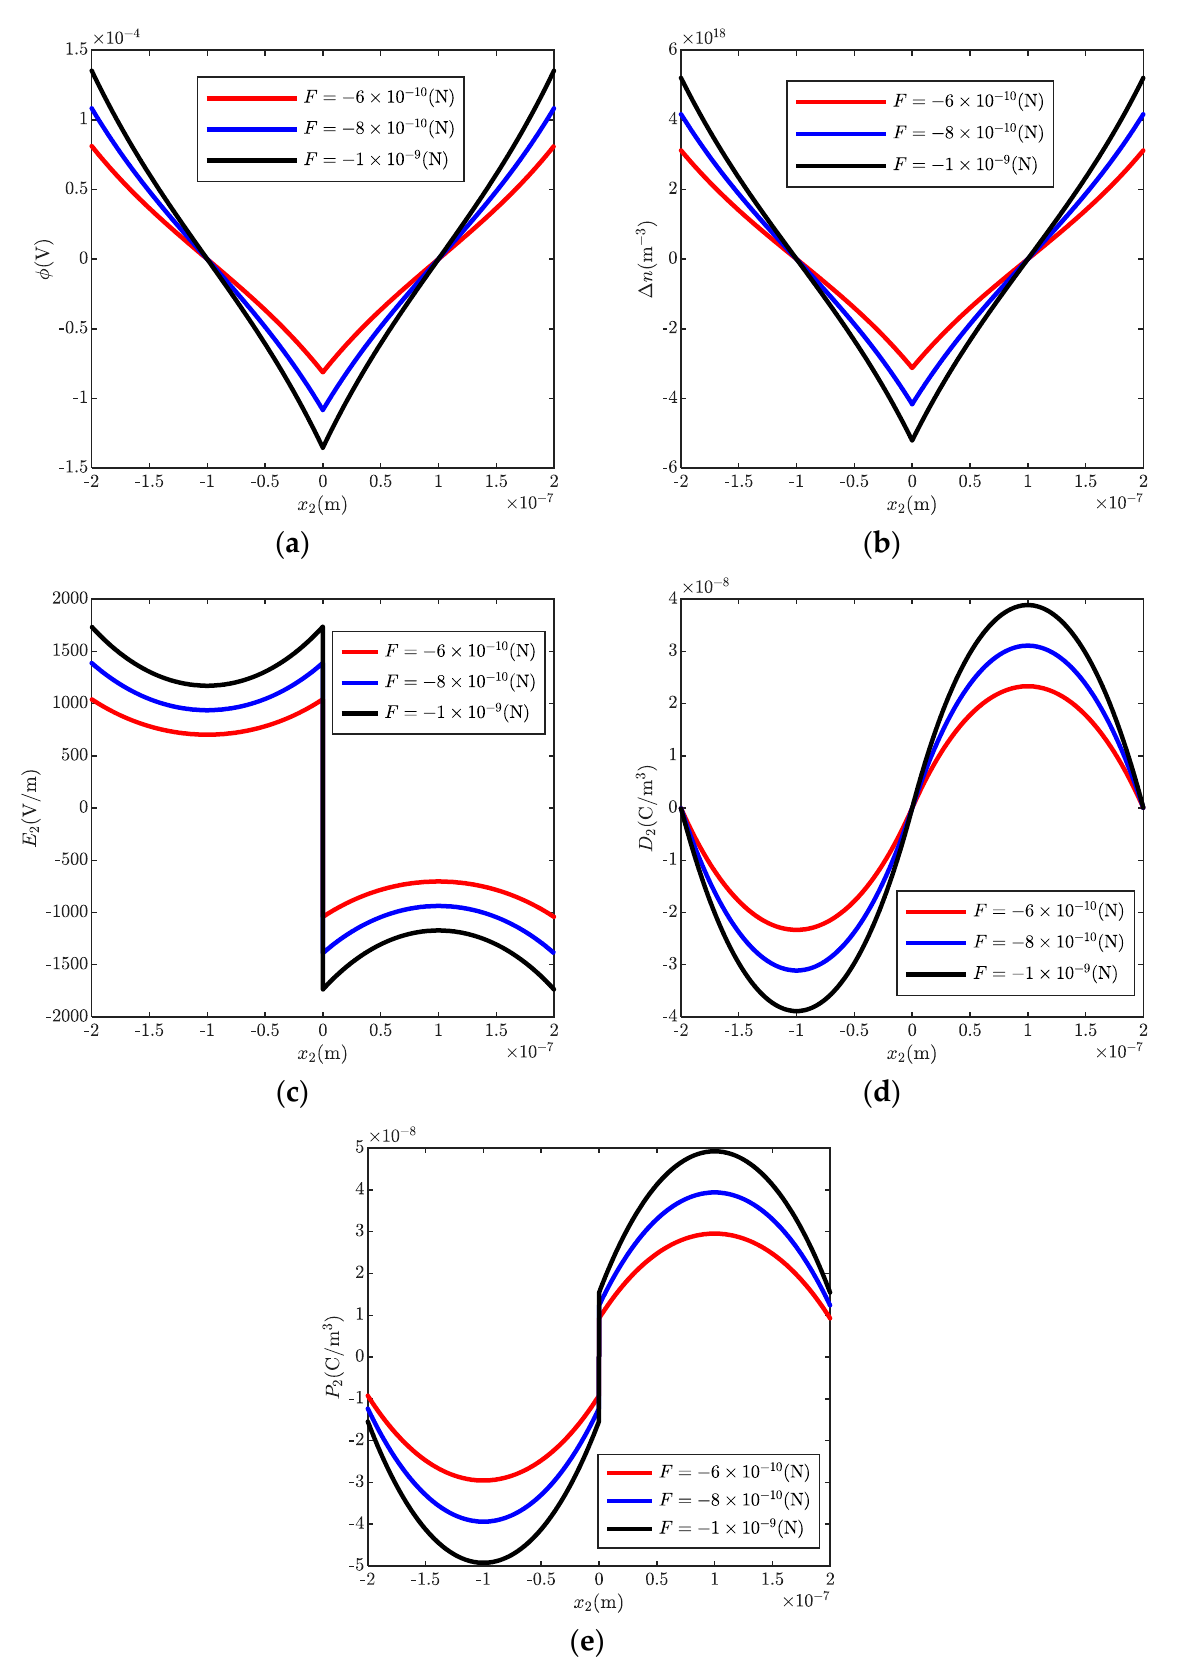
Figure 4. Electrostatics in a ZnO bi-layer with different transverse shear forces. ( a ) electric potential φ , ( b ) carrier concentrations ∆ n , ( c ) electric field E 2 , ( d ) electric displacement D 2 , ( e ) polarization P 2 .